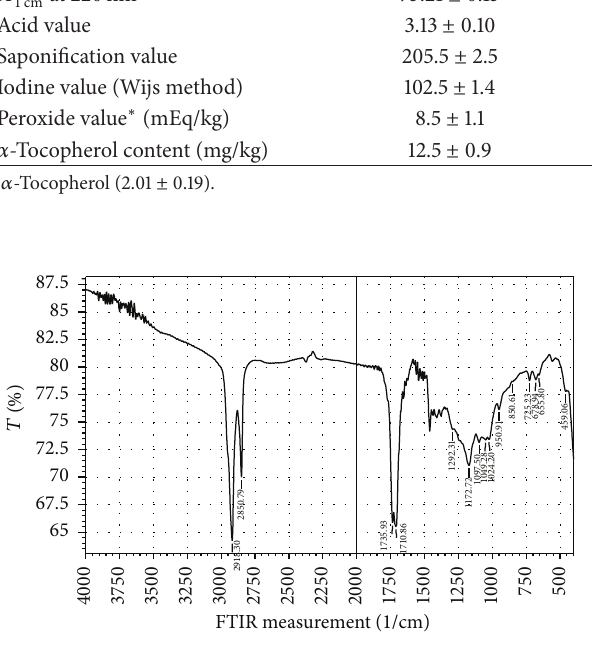
Figure 1: IR spectrum of fixed oil of Annona muricata L. seed (as thin film, number of scans: 30, resolution: 4cm −1 , apodization;